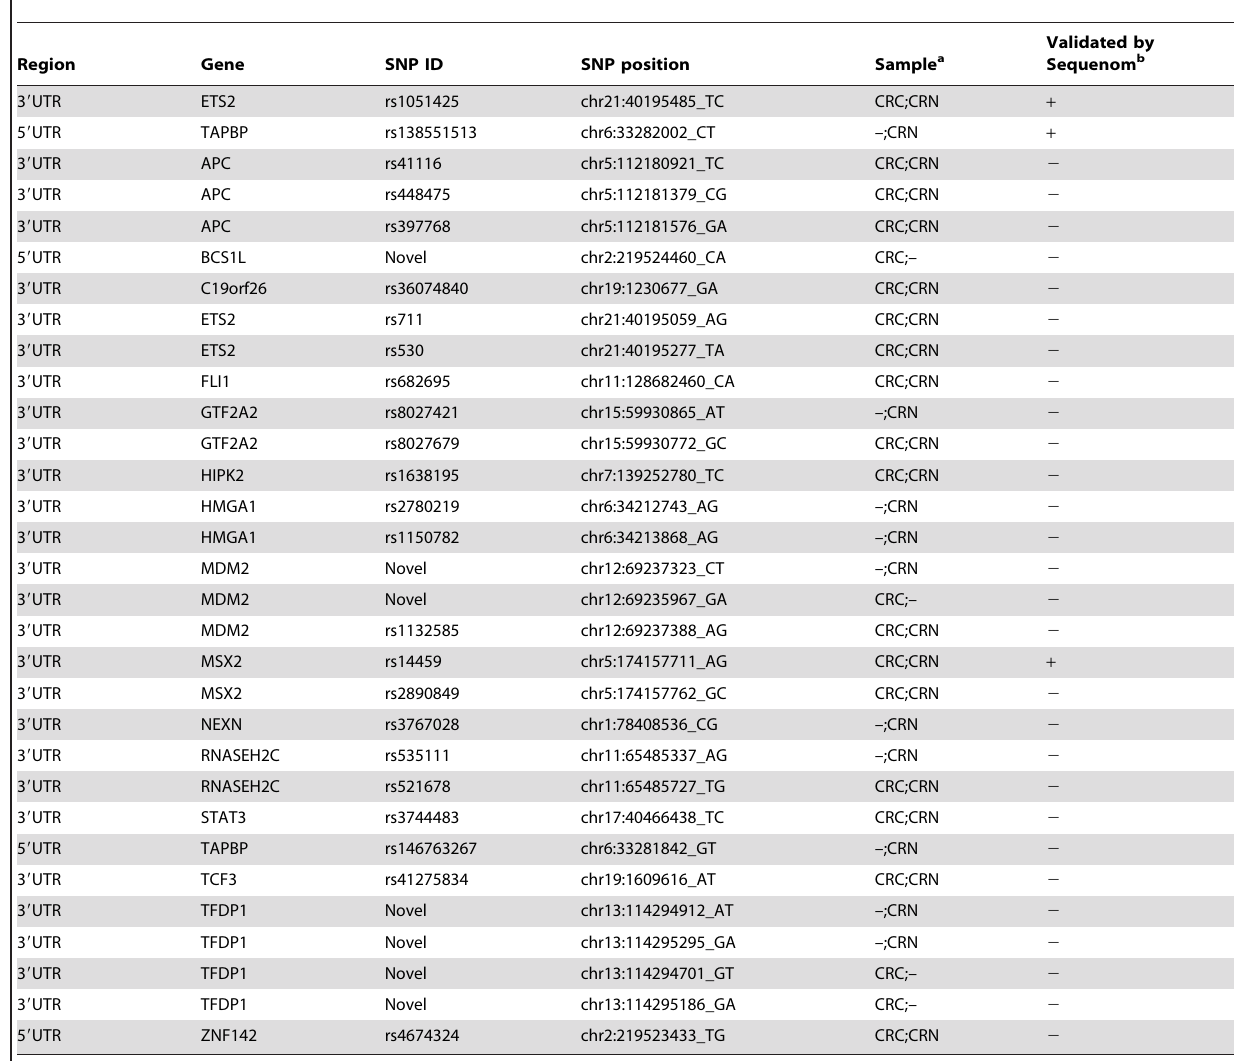
Table 4. List of UTR SNPs with transcription factor binding sites changed using TFSEARCH.